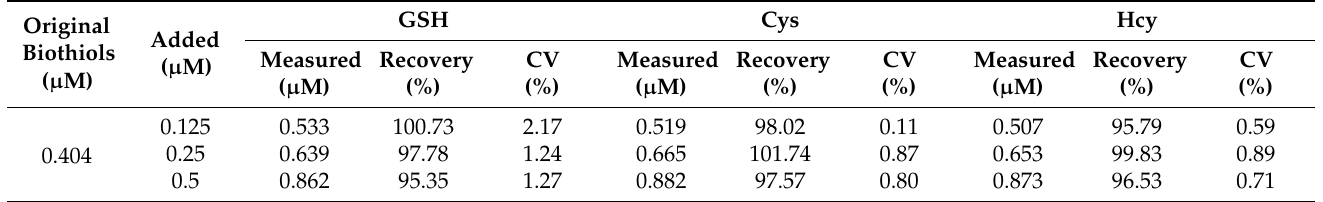
Table 1. Determination of biothiols in spiked human serum using HRP-Cu NFs-based assay